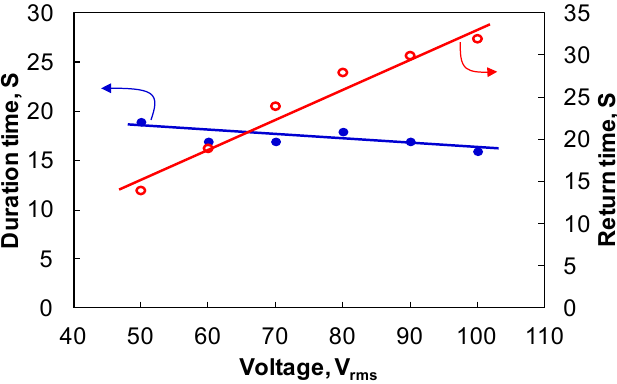
Figure 6. Duration time and returning time when the droplet is pulled to move 7 mm with different